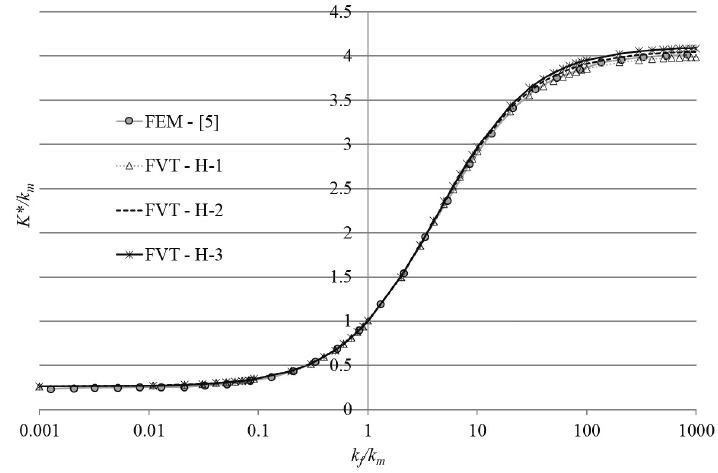
Figure 8. Normalized effective transverse thermal conductivity of the composite with hexagonal distribution of fibers.